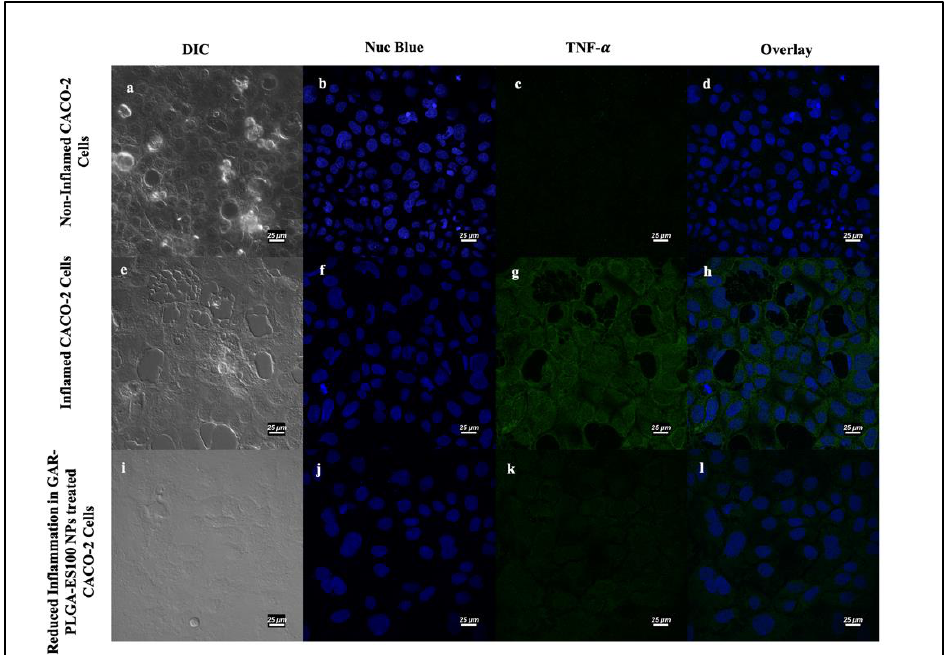
Figure 9. Induction and inhibition of inflammation in CACO-2 cells by confocal microscopy: non- inflamed CACO2 cells ( a – d ); inflamed CACO-2 cells treated with proinflammatory cocktail com- prising of IL-6, TNF-α, and LPS at 0.4, 0.9, and 30 μg/mL, respectively, for 3 h used to observe the expression of TNF- α ( e – h ). Reduction in the expression of TNF- α occurred in CACO-2 cells after treatment with GAR-PLGA-ES100 NPs (250 μg/mL) for 48 h ( i – l ) (at scale 25μm).